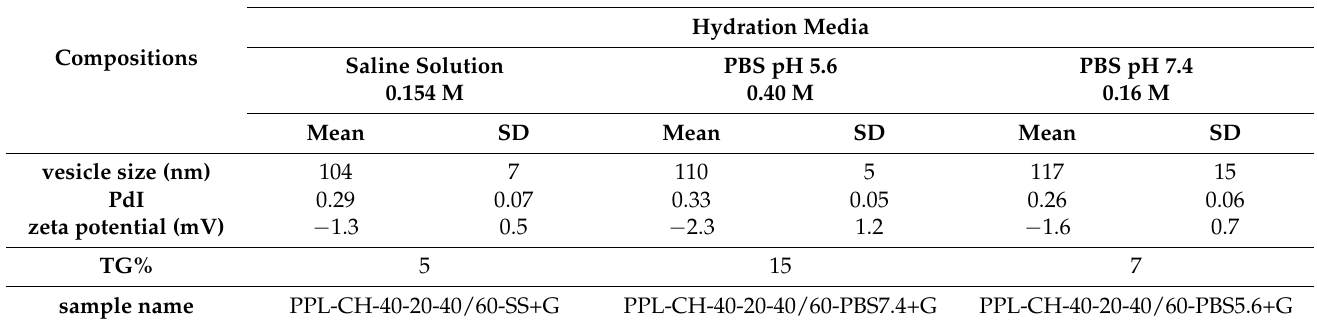
Figure 10 represents the AFM measurement results in the case of the PPL-CH-55-5- 40/60-SS+G (Figure 10A) and the PPL-CH-55-5-40/60-PBS7.4+G (Figure 10B) samples, which differ only in the quality of the hydration media. The images show homogeneous size distribution and vesicles with 100–120 nm size, supporting the results of the DLS